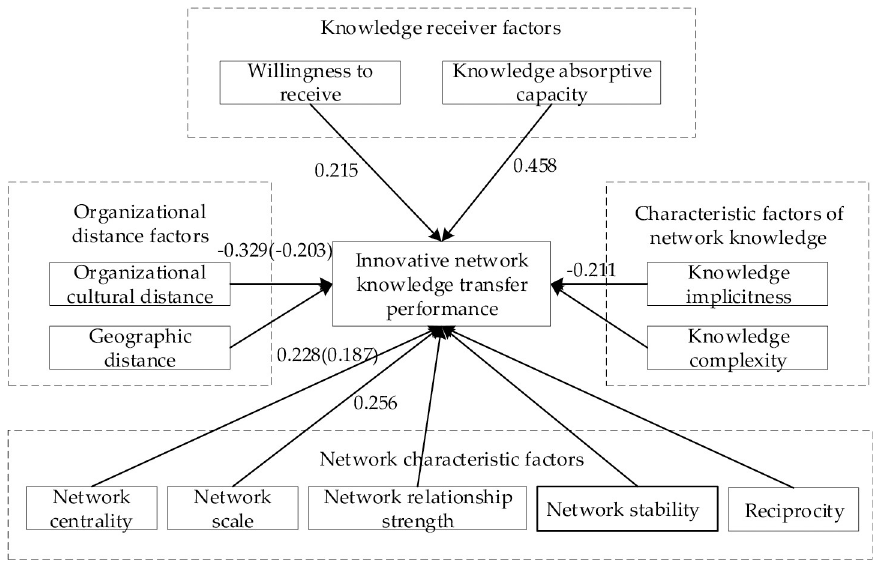
Fig 2. Results of classified regression and stepwise regression